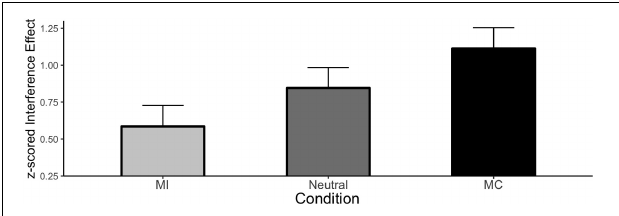
FIGURE 4 | ISPC effect in Experiment 2. Error bars represent the 95% HDI.